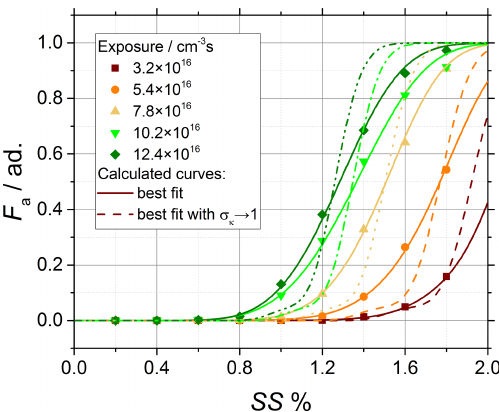
Figure A2. Sensitivity analysis performed on chemically aged soot particles sampled from the turbulent jet flame supplied with liq- uid kerosene at 70mm HAB. CCNc activation curves of the soot particles obtained after chemical aging with ozone and comparison of the experimental data (data points) to activation curves calcu- lated with σ κ, geo = 1 . 01 (dashed lines) and best fit with σ κ, geo = 1 . 93 ± 0 . 14 (solid